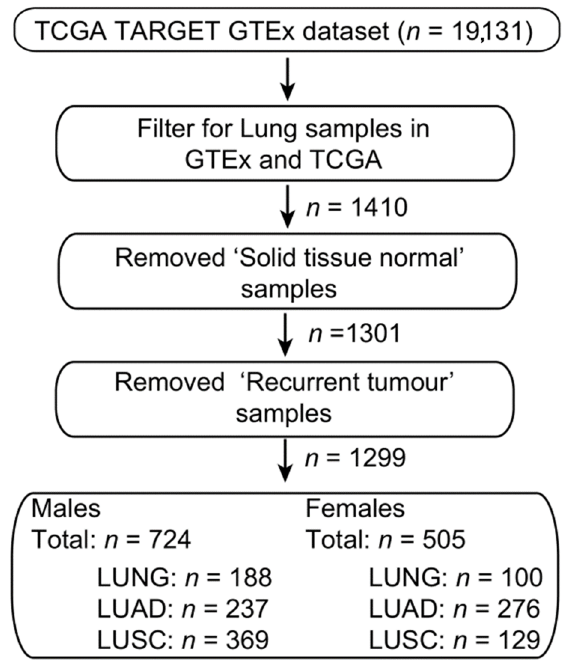
Figure 8. Workflow for the extraction and pre-processing of TCGA and GTEX samples from the UCSC Xenabrowser.